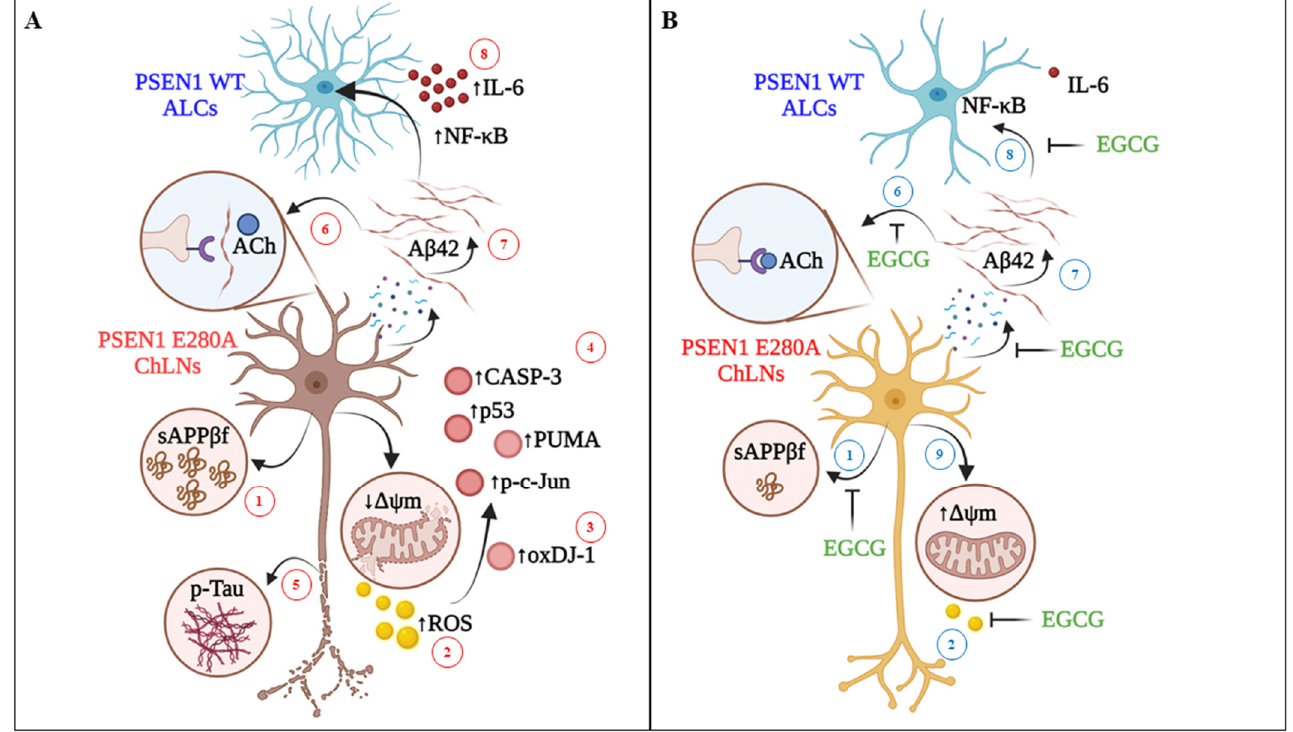
Figure 8. Schematic representation of the protective effect of EGCG on PSEN 1 E280A ChLNs. ( A ) Intracellularly accumulation of sAPP β f (step 1) generates H2O2 (s2), which in turn oxidizes the OS sensor protein DJ-1 at Cys106-SH residue into DJ-1Cys106- SO3 (s3) and activates a domino-like, pro-death signaling mechanism (s4) by triggering the activation of transcription factor P53 and c-JUN, BH-3-only protein PUMA and CASP-3. Interestingly, (i)sAPP β f induces the phosphorylation of protein TAU (p-TAU, s5). Besides, PSEN 1 E280A ChLNs do not respond to ACh stimuli i.e., intracellular transient Ca 2+ increase is missing due to extracellular interaction between (e)A β 42 and nicotinic (n)ACh receptors (s6). Therefore, the (i)sAPP β f/A β 42-induced signaling process (s1-s6) leads ChLNs to structural alterations, cell death (apoptosis), as well as intracellular Ca 2+ dysfunction. To aggravate matters, the (e)A β 42 (s7) induces ALCs to secrete pro-inflammatory cytokine IL-6 through activation of transcrip- tion factor NF- κ B (s8). ( B ) Upon exposure to EGCG, mutant ChLNs show normal features such as no oxidized protein DJ-1 (s3), unaltered ∆Ψ m (s9), and intact nuclei morphology. Moreover, EGCG partially inhibits the aggregation of (i)sAPP β f (s1) and blocks the generation of H2O2 (s2). As a result, there is no further activation of pro-death proteins (s4), and phosphorylation of protein TAU (s5). Furthermore, EGCG reestablishes the PSEN1 E280A ChLNs response to ACh (s6–7) and protects ALCs against (e)A β 42-induced pro-inflammation stimuli (s8).